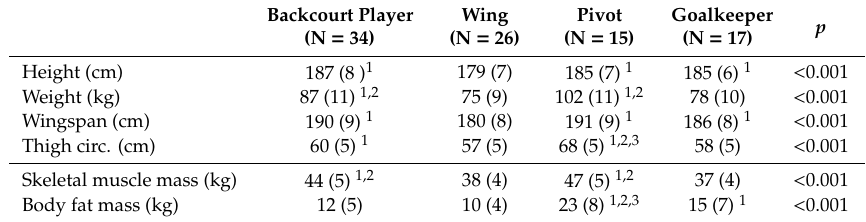
Table 1. Di ff erences between playing positions in anthropometric characteristics and body composition. Backcourt Player (N = 34)